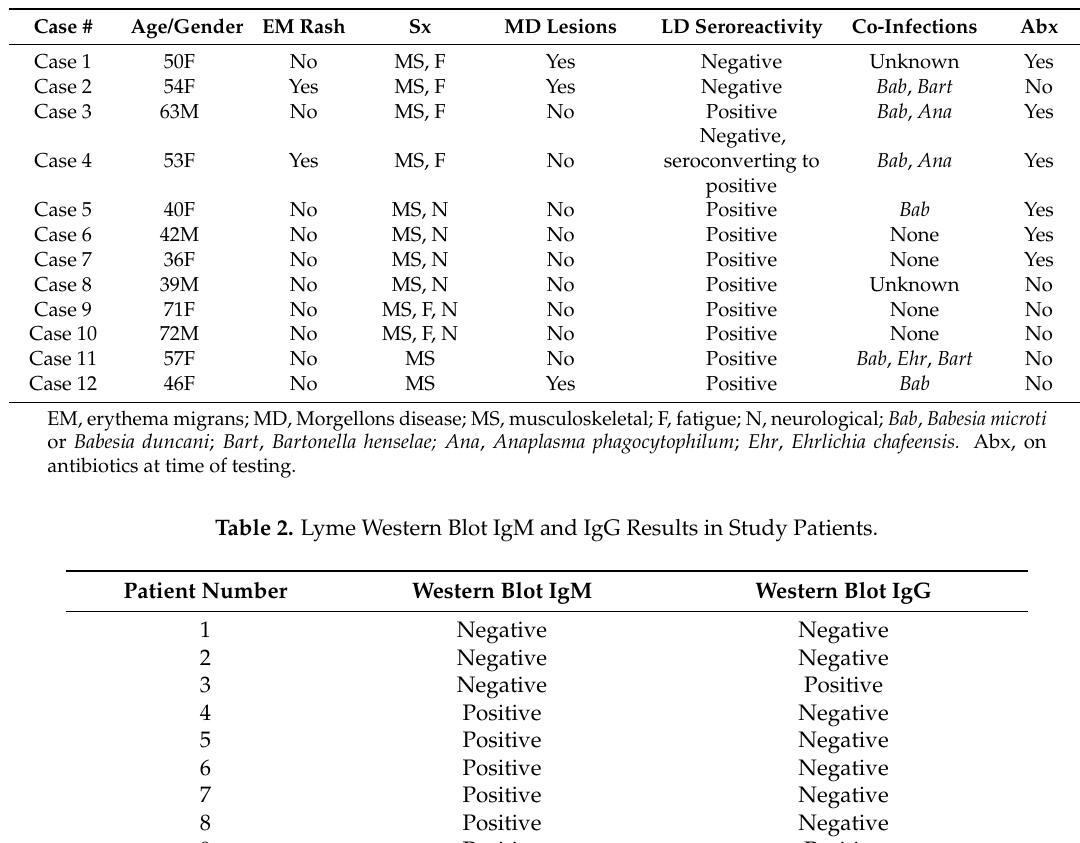
Table 1. Clinical Characteristics of Study Patients.